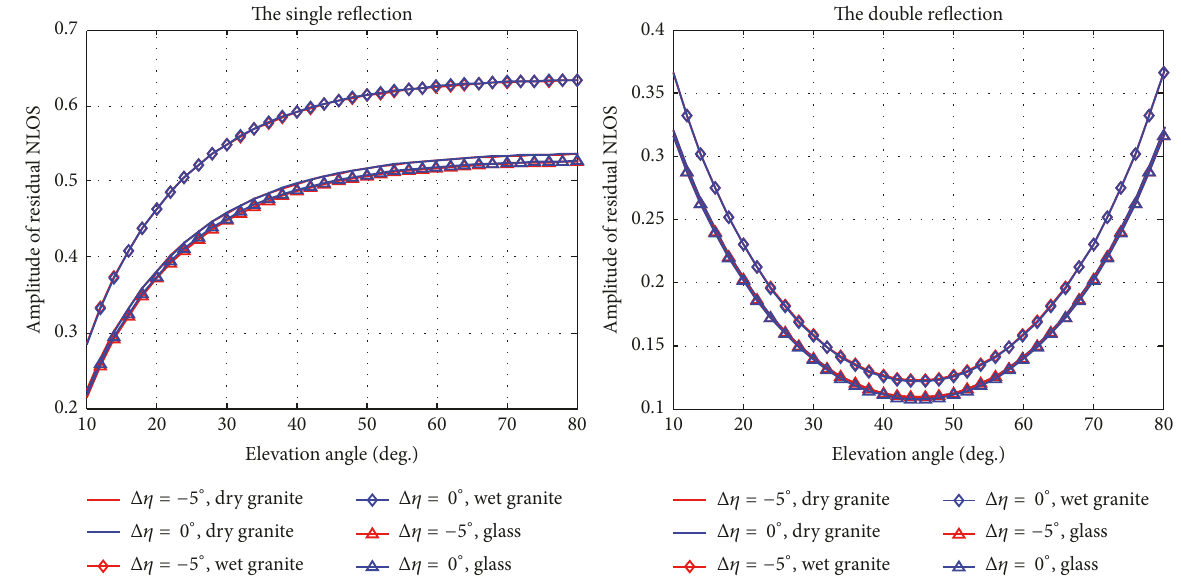
Figure 6: The magnitude of residual NLOS